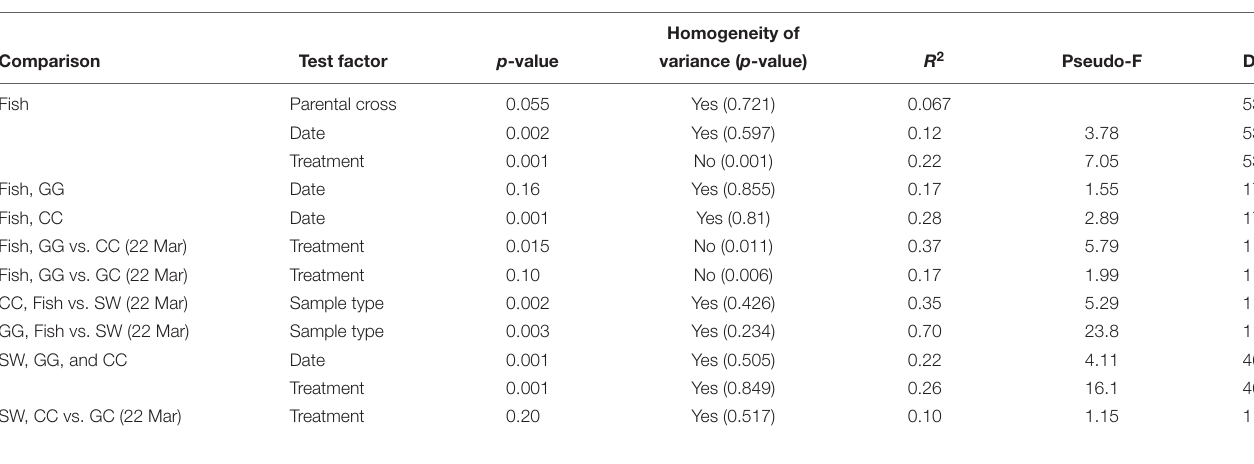
FIGURE 3 | Bray–Curtis PCoA of all samples taken during the experiment. Samples are faceted according to type and treatment. Dates are represented by different colors. Percentage variation explained by each axis is given in brackets. Seawater microbial communities changed over time and were influenced by treatment. Fish samples did not cluster together closely, especially those in the claywater treatment. TABLE 1 | PERMANOVA and Betadisper